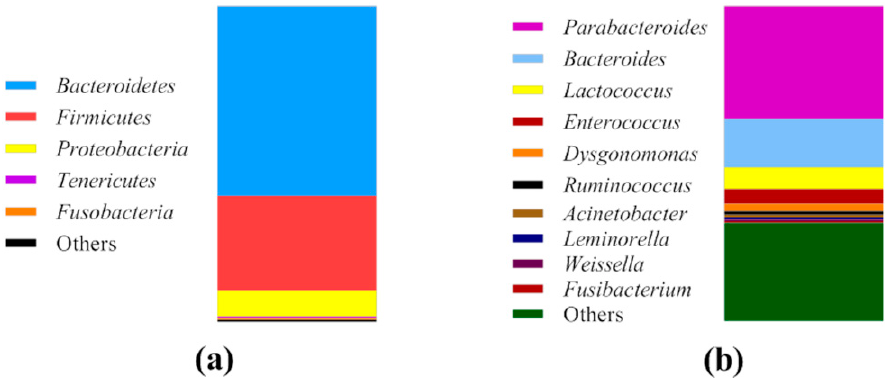
Figure 1. Relative abundance (%) of the phyla ( a ) and genera ( b ) present in cricket powder.